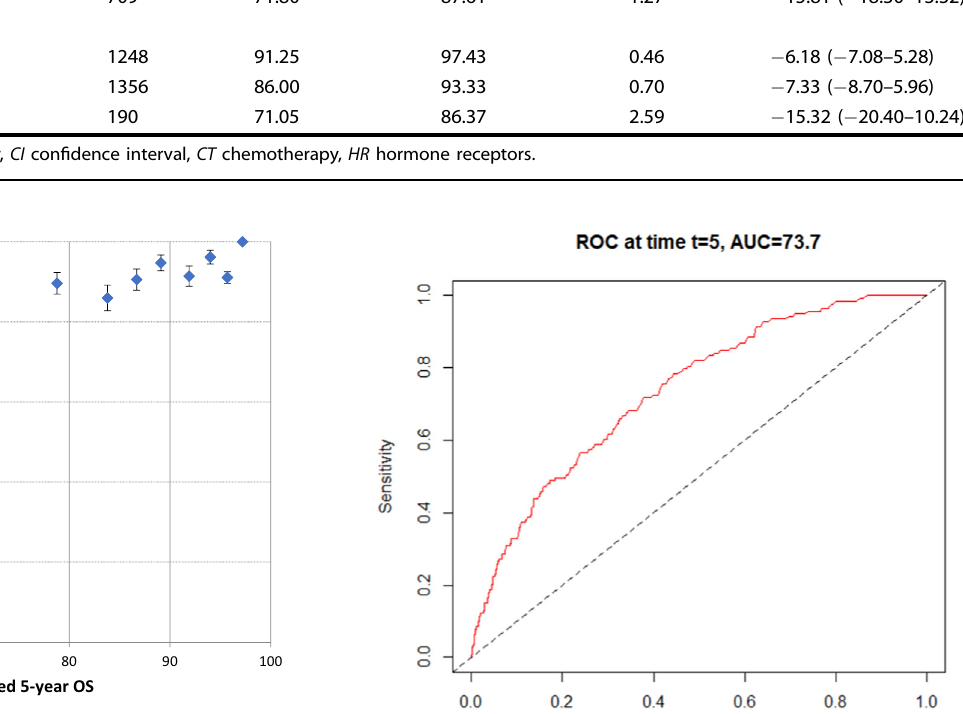
Fig. 2 Calibration plot showing observed versus predicted 5-year overall survival: for each decile of the predicted 5-year overall survival, the mean observed 5-year overall survival is presented, with error bars presenting the standard error. OS overall survival.